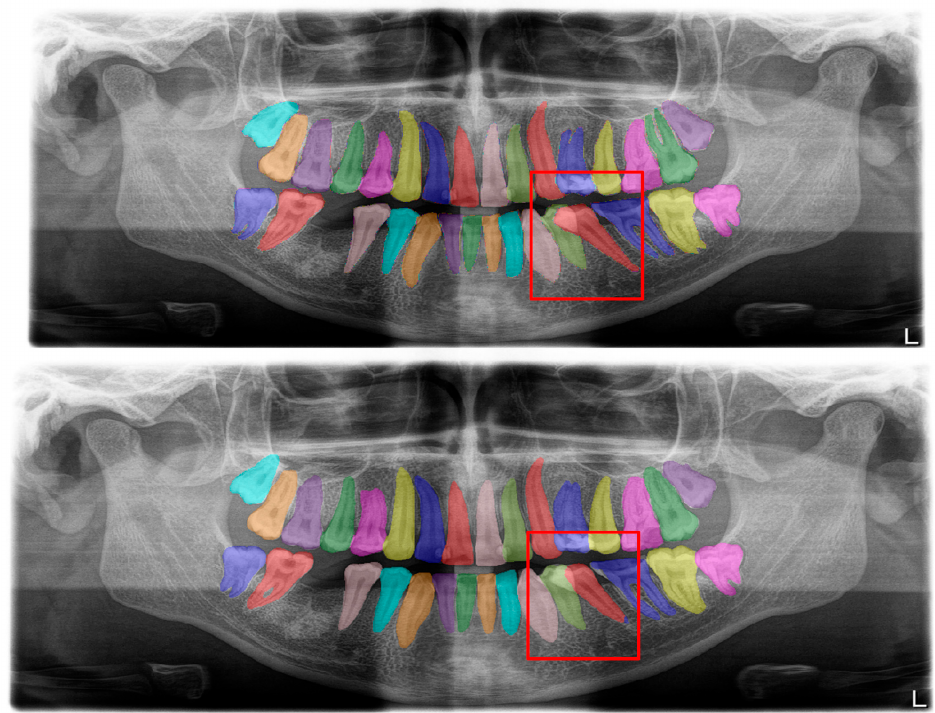
Figure 9. Erroneous automatic segmentation at the mandibular left second molar due to the super- imposition between the mandibular left first and mandibular left second premolars. Manual seg- mentation (upper image) and automatic segmentation (lower image) can be seen above. In Figure 10, it can be seen that a wide amalgam restoration in the mandibular left first premolar tooth was mis-segmented as a crown restoration. The mis-segmentation of wide amalgam restorations was seen in a total of five OPGs.